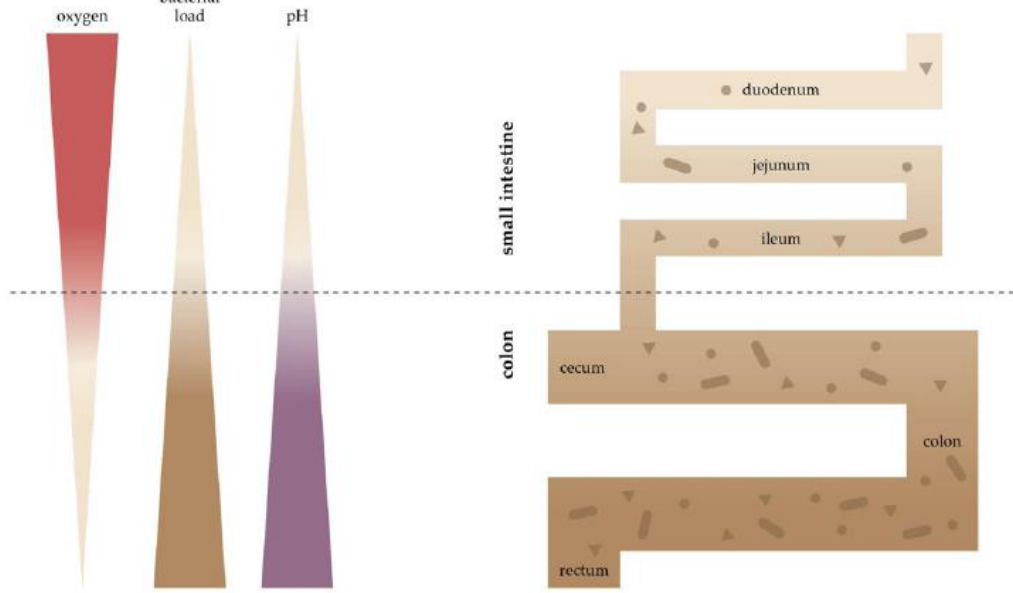
Figure 2. Longitudinal gradient of O 2 , bacterial load and pH along the intestine. Spatial heterogeneity of the gut microbiota in the gastrointestinal tract. The bacterial families of the small intestine and colon reflect physiological differences along the length of the gut. A gradient of oxygen and pH limits the bacterial density in the small intestine, whereas the colon carries high bacterial loads (darker brown = more bacteria).